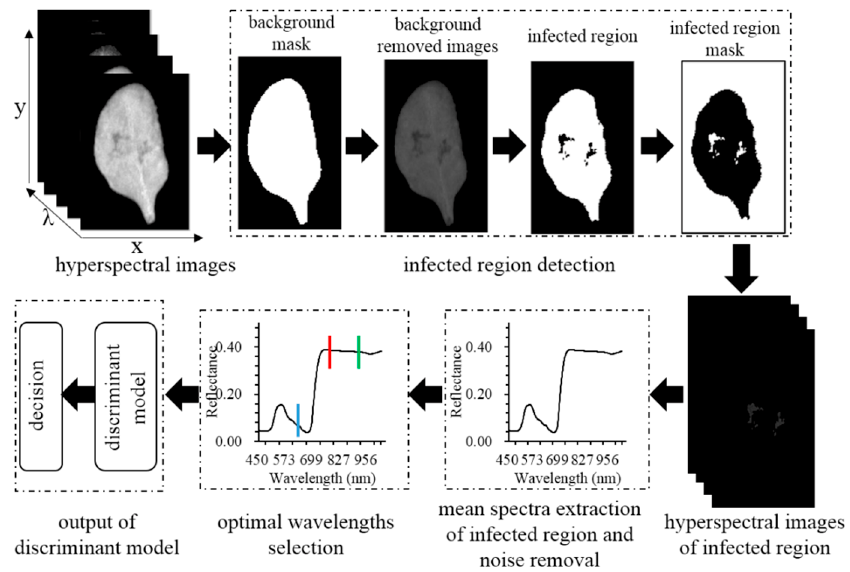
Figure 1. The pipeline of Sclerotinia stem rot (SSR) detection based on hyperspectral imaging.